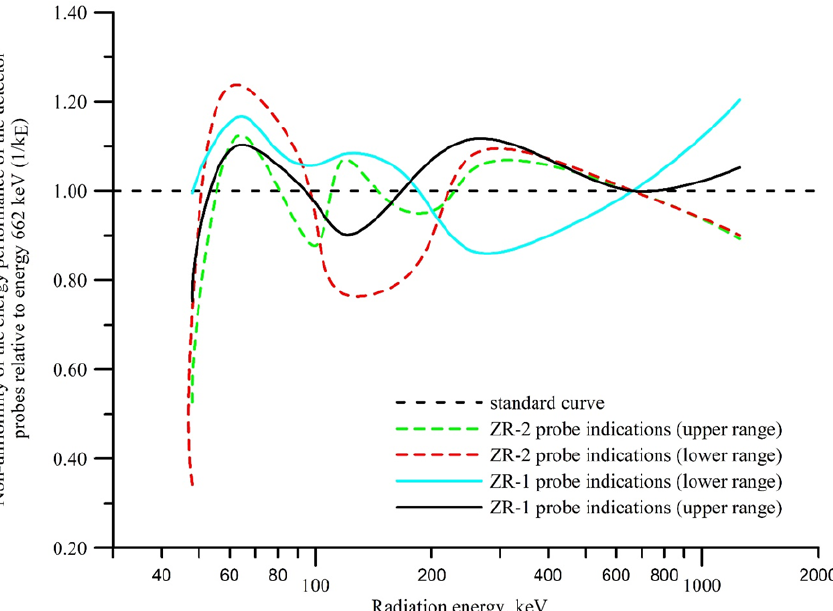
Figure 7. Changes in indications of the dosimetric probes: ( solid line ) the ZR-1 probes in the upper measuring range from 32 mGy/h to 16 Gy/h and the lower range from 0.5 µGy/h to 25 mGy/h; ( dashed line ) the ZR-2 probe in the upper measuring range from 75 mGy/h to 24 Gy/h and the lower measuring range from 0.4 µGy/h to 75 mGy/h.